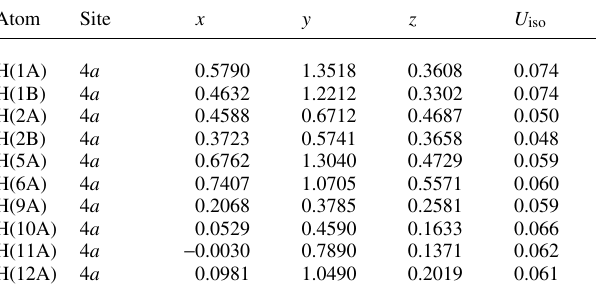
Table 2. Atomic coordinates and displacement parameters (in Å 2 )